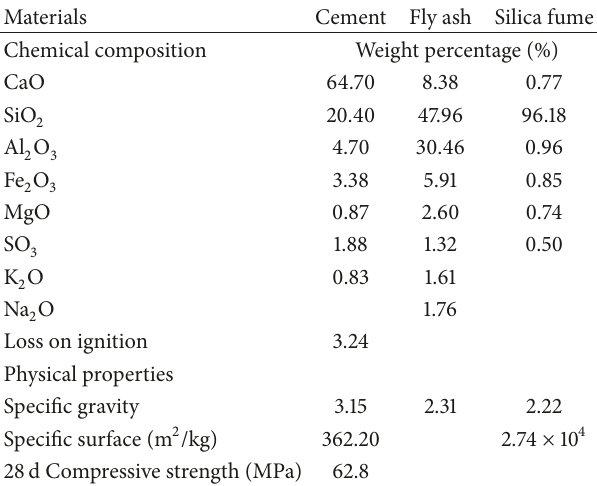
Table 1: Chemical composition and physical properties of cement and mineral